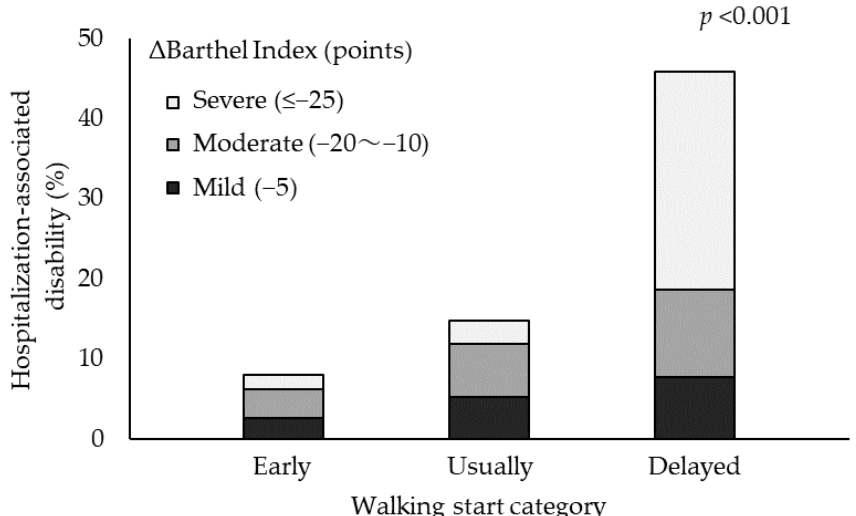
Figure 3. Barthel Index change by the walking start category. The decrease of − 5 points was 33% in the early-start walking group, 44% in the usual-start walking group, and 20% in the delayed-start walking group; the decrease of − 20 to − 10 points was 44%, 33%, and 19%, respectively; and the decrease of − 25 points or more was 22%, 22%, and 61%, respectively. Univariate logistic regression analysis revealed age, sex, albumin level, haemoglobin Table 3. Clinical characteristics according to walking onset